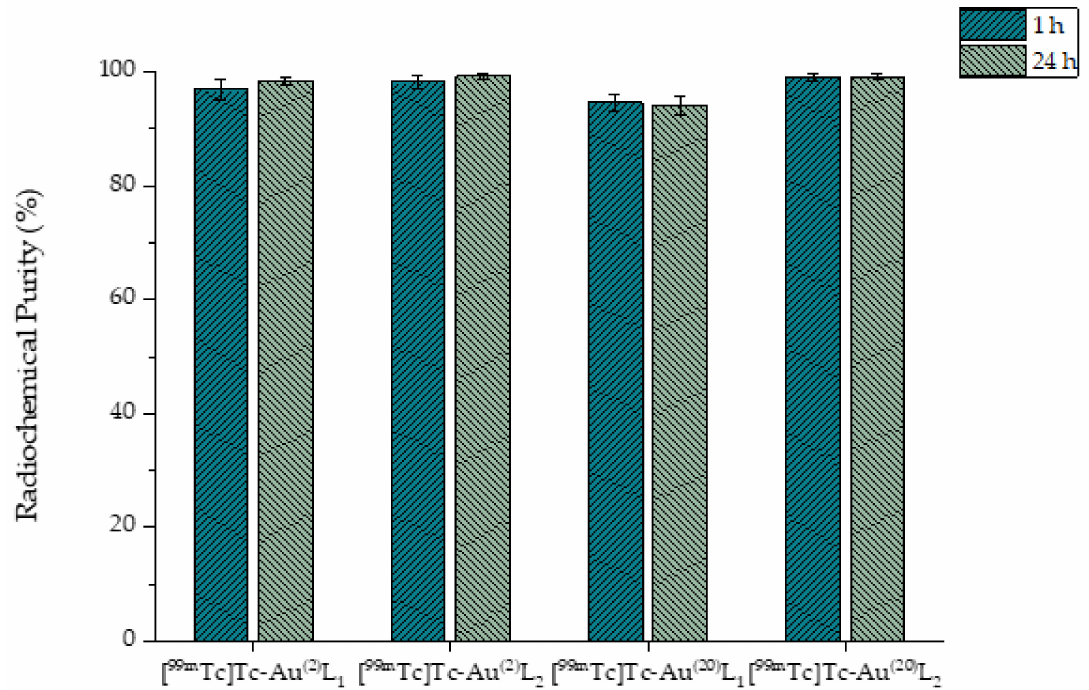
Figure 8. HPLC results representing the radiochemical purity of [ 99m Tc]Tc-Au (2) L1, [ 99m Tc]Tc-Au (2) L2, [ 99m Tc]Tc-Au (20) L1, and [ 99m Tc]Tc-Au (20) L2 at 1 h and 24 h